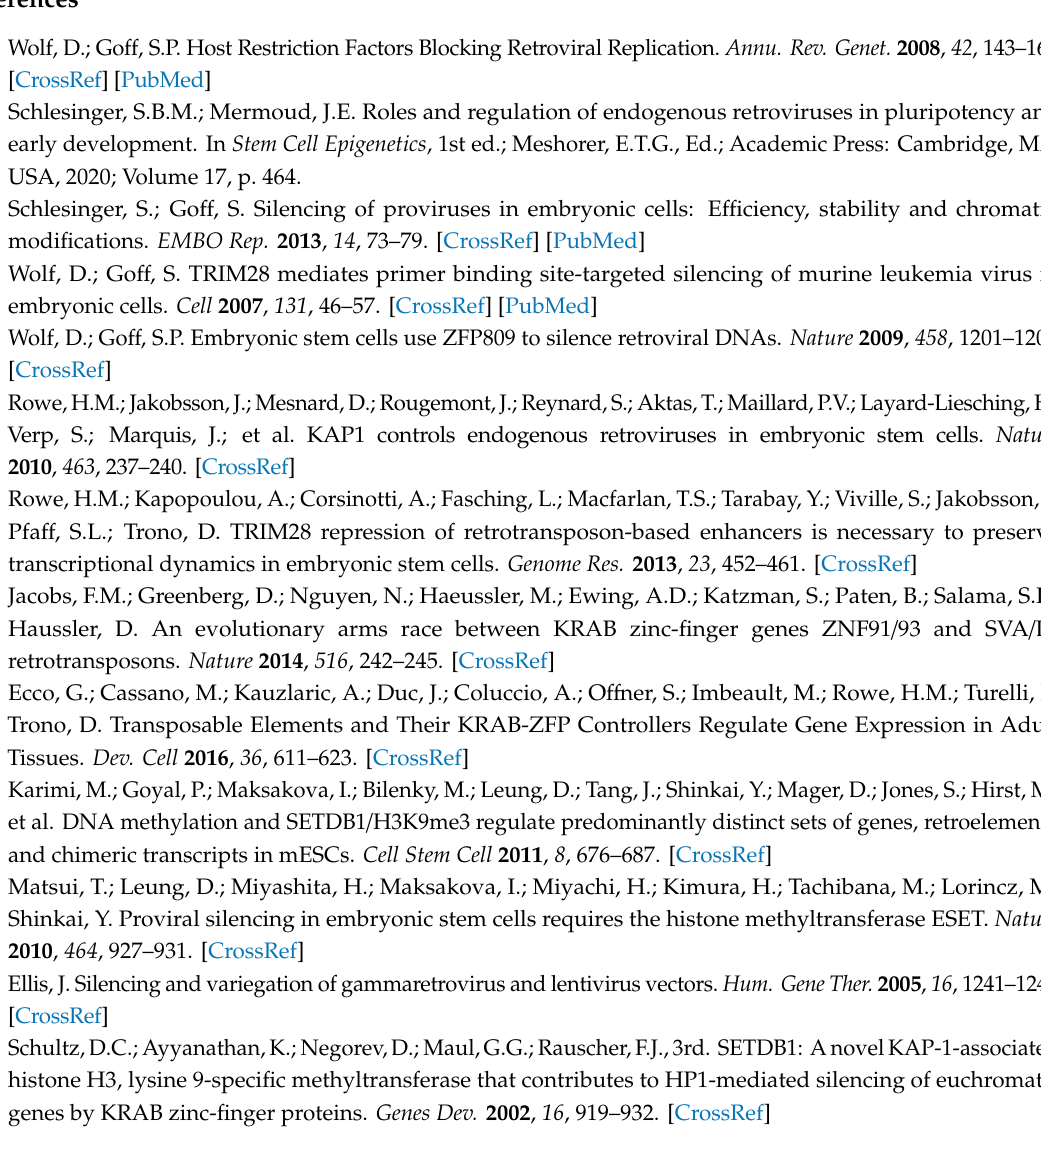
Figure S1: IP with anti Trim24 ; Figure S2: RT-qPCR and ChIP on ERVs; Figure S3: NIH3T3 control and copy number of MLV infection; Figure S4: Bisulfite analysis of proviral DNA; Table S1: Primers